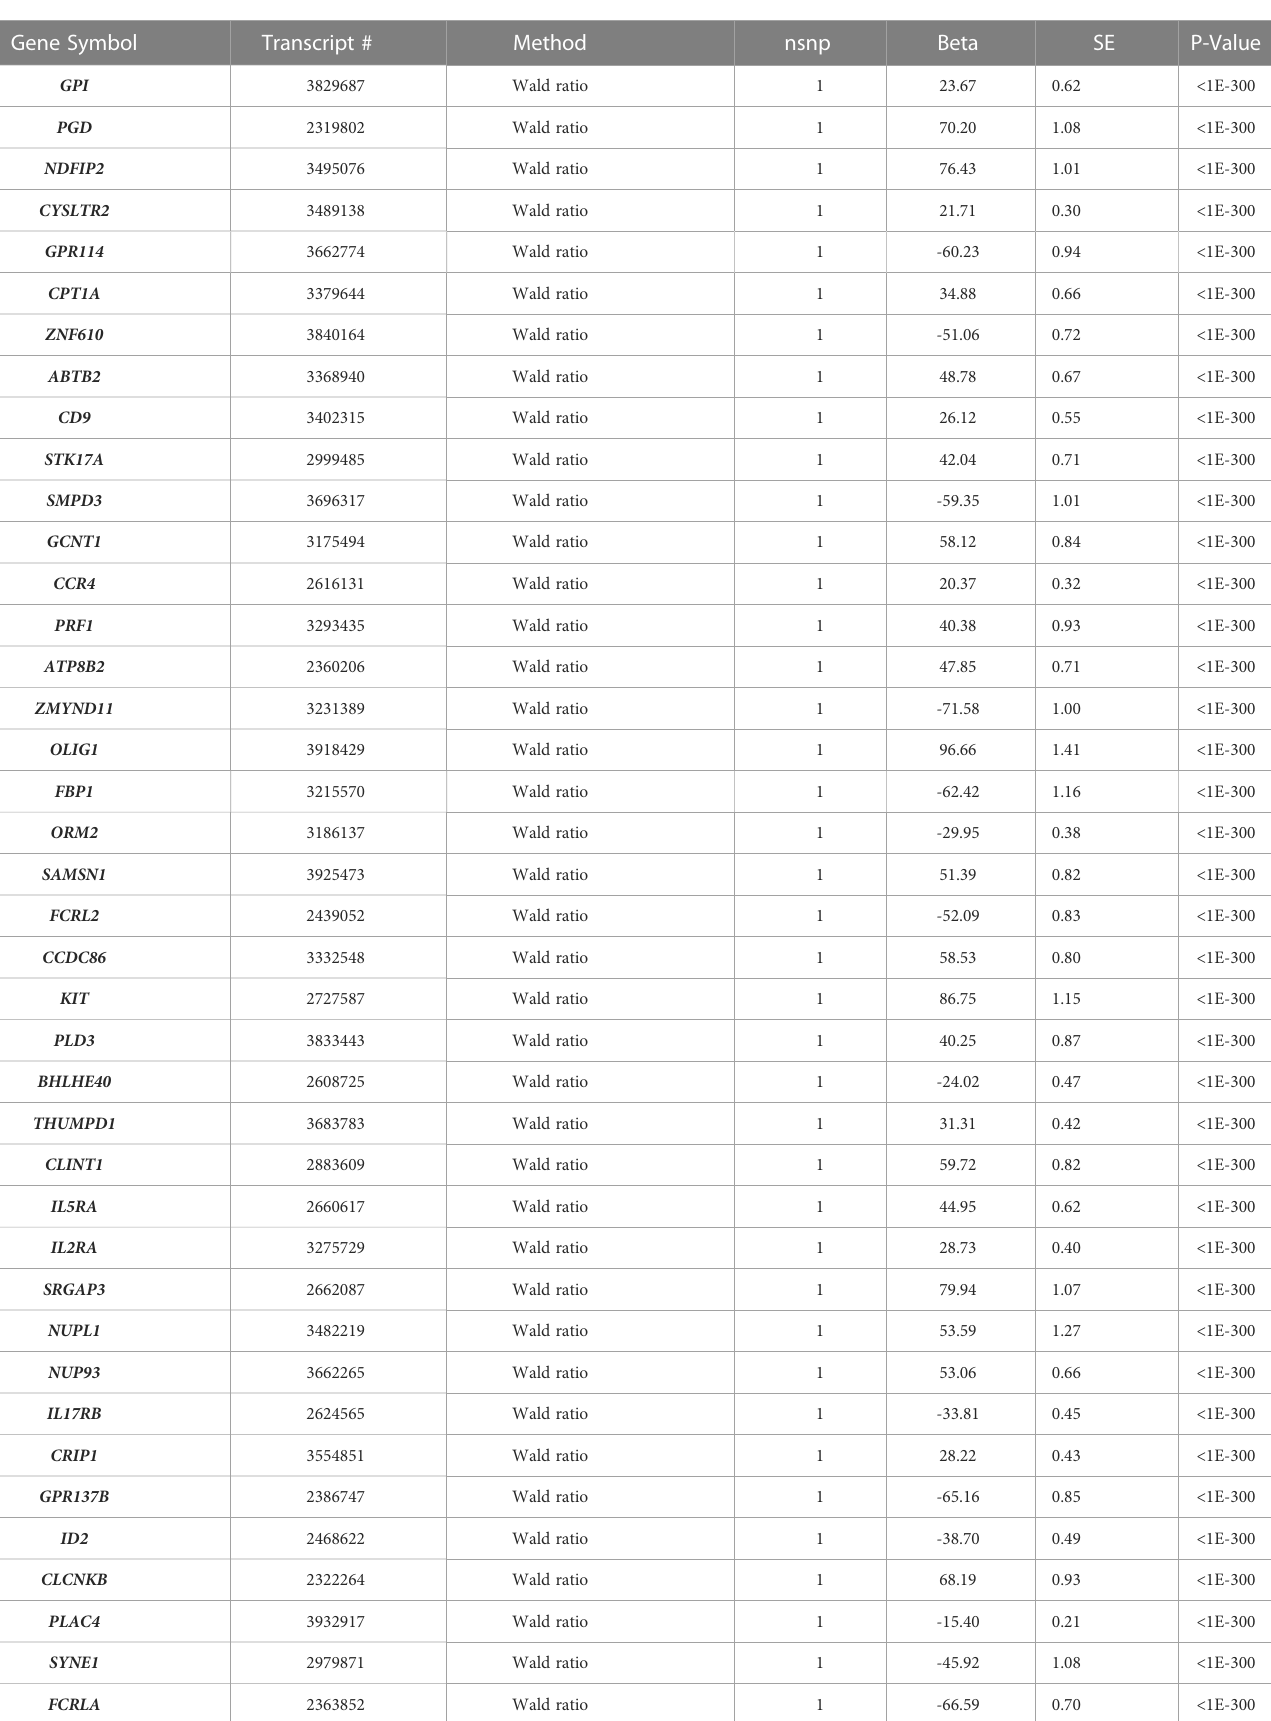
TABLE 6 MR results for genes putatively causal for asthma at Bonferroni-corrected p<2.70×10 -4 (n=70). Gene